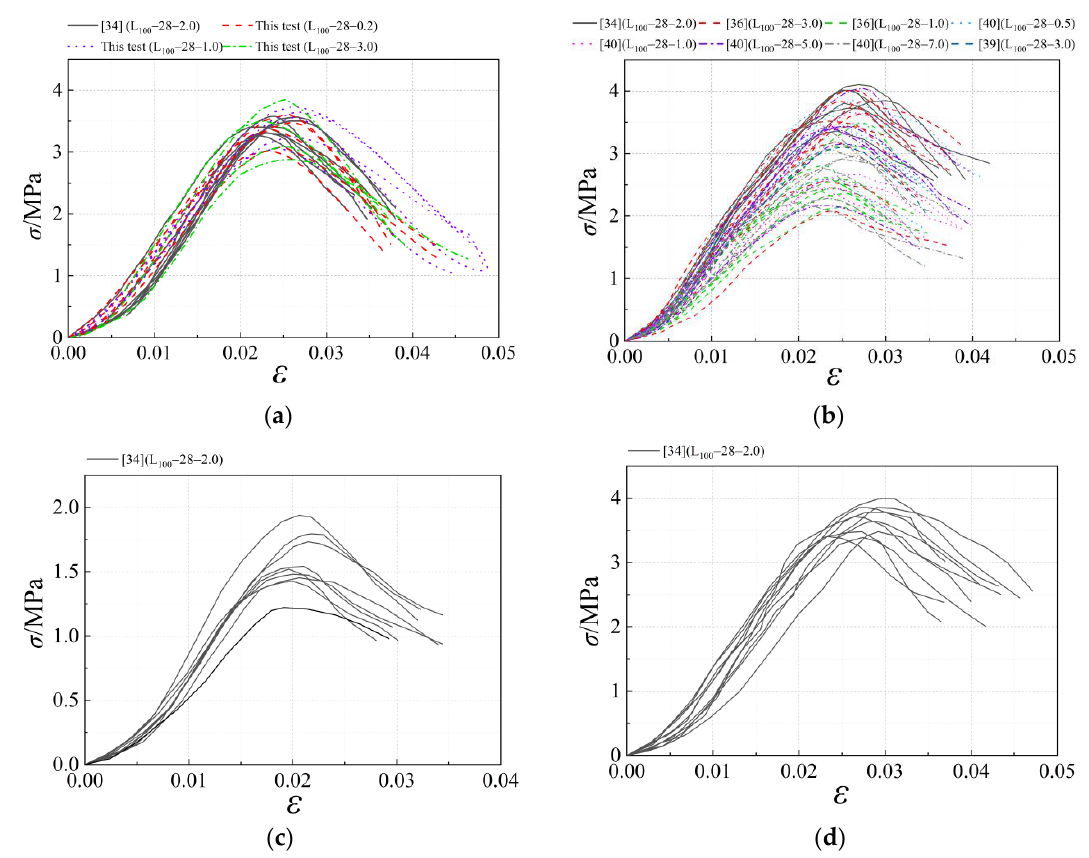
Figure 12. Summary of the original uniaxial compressive stress-strain curves in the related literature: ( a ) Earth from Xinjiang; ( b ) Earth from Shanxi; ( c ) Earth from Fujian; and ( d ) Earth from Heilongjiang. First, the test constitutive curve was normalized. Then, the equations were fitted according to the least squares principle using Origin 8.5 software to determine the values of the curve shape parameters for the rising and descending sections of each literature-fitted curve. Finally, the fitting effect of the present constitutive equation is judged according to the coefficient of determination R 2 . The results of the curve shape parameter calculation